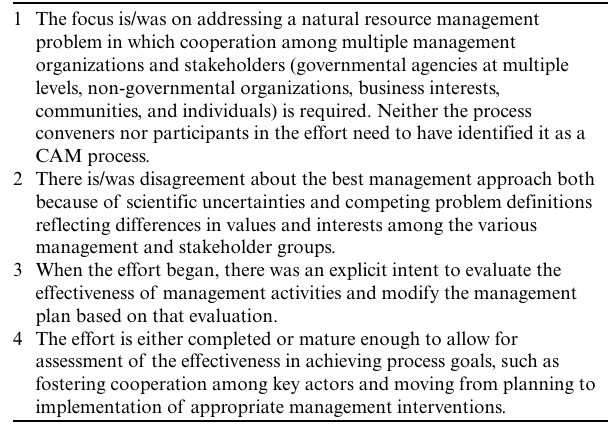
Table 1 . Criteria for classifying natural resource management projects as collaborative adaptive management (CAM)